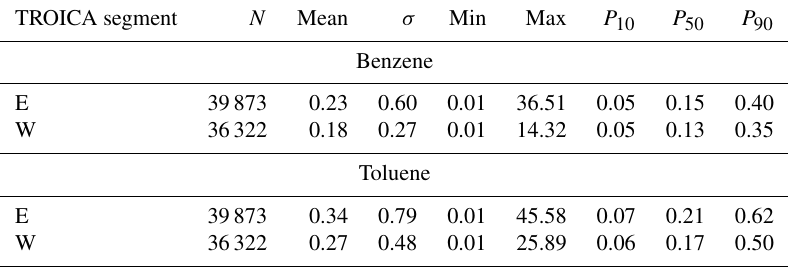
Table 1. Statistics for the filtered original 10s data of benzene and toluene (inppb) from the TROICA-12 campaign (E – east segment; W – west segment). N – total number of the original 10s filtered samples; σ – standard deviation; P –